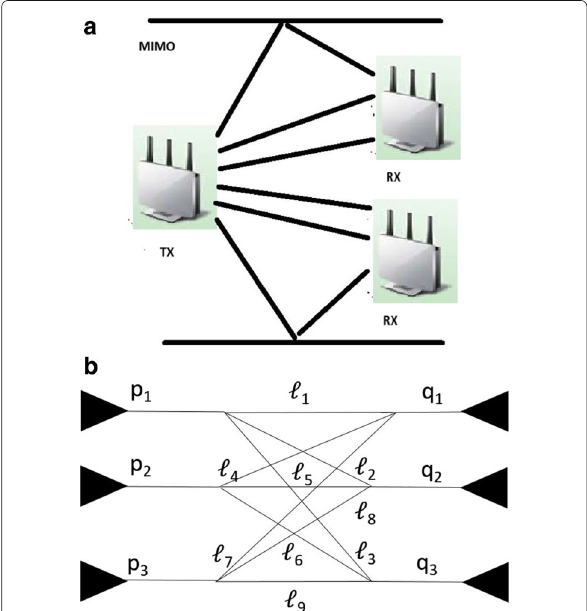
Fig. 1 a MIMO scenario with one TX and two RX WiFi devices. Each RX node is equipped with M r = 3 receiving antennas while the TX node is fitted with M t = 3 transmitting antennas. b For each TX-RX communication, the generic MIMO link (cid:2) j is also identified by the couple ( u , v ) corresponding to the transmitter p u and the receiver antenna q v . For instance, link (cid:2) 4 is identified by p 2 and q 1 , i.e., by the antenna pair ( u = 2, v = 1